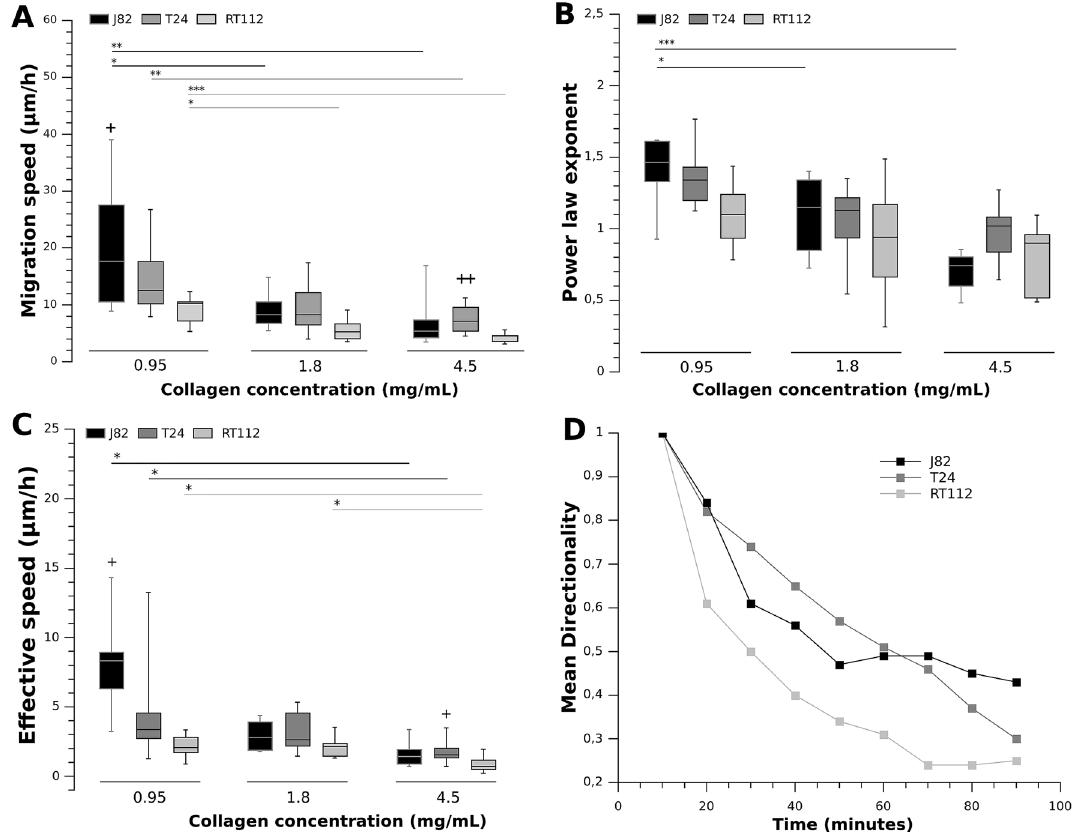
Figure 1. Effect of cell metastatic potential and collagen concentration on ( A ) migration speed, ( B ) power law exponent, ( C ) cell effective speed, ( D ) Mean directionality (at 0.95 mg/mL). Three cancer cell lines of increasing invasiveness (RT112 < T24 < J82) and collagen gel concentration (0.95 mg/mL, 1.8 mg/mL and 4.5 mg/mL) were used. Power-law exponents α in ( B ) were obtained from MSD(t) = D ( t / t 0 ) α . Box-whisker plots indicate median value, 25% and 75% quartiles and whiskers extend to the 5% and 95% percentiles ( A – C ). Statistical significance from another collagen concentration * corresponds to p < 0.05, ** corresponds to p < 0.01, *** corresponds to p < 0.001. Significant difference (+) from RT112 cells (+ p < 0.05, ++ p < 0.01). Cell number: ( A ) and ( C ) For 0.95 mg/mL, N = 9, 10, 7 respectively for J82, T24, RT112 cells. For 1.8 mg/mL, N = 8, 9, 7. For 4.5 mg/mL, N = 10, 13, 9. ( B ) For 0.95 mg/mL, N = 8, 9, 7 respectively for J82, T24, RT112 cells. For 1.8 mg/mL, N = 7, 8, 7. For 4.5 mg/mL, N = 8, 9, 9. ( D ) Graph representing the mean directionality vs. time for the three cancer cell lines at 0.95 mg/mL.